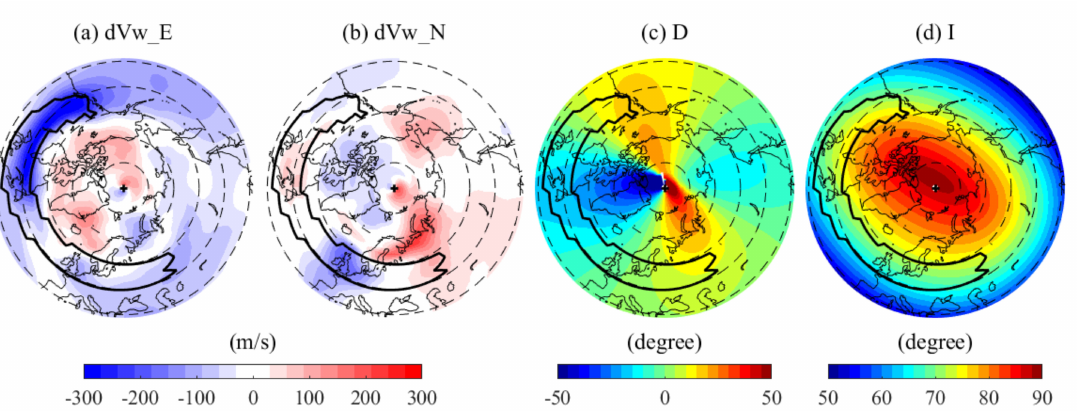
Figure 6. The difference of ( a ) eastward neutral wind and ( b ) northward neutral wind between TIEGCM with and without SAPS. The distribution of ( c ) geomagnetic declination and ( d )